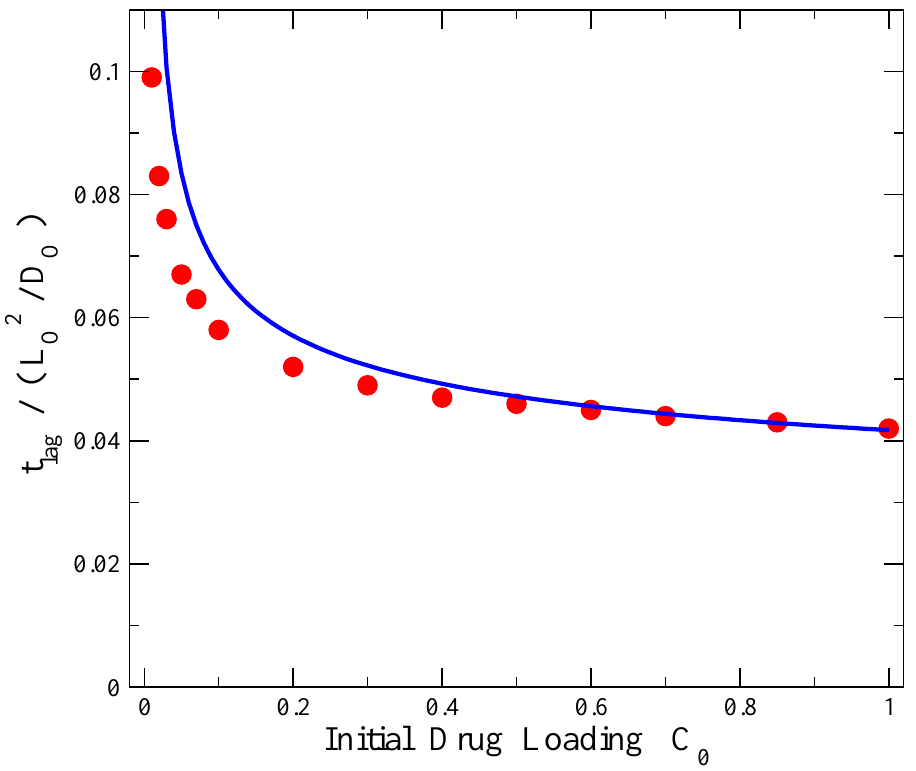
Figure 7. Dimensionless lag time, t lag / L 2 /D O , as a function of the initial concentration C 0 of the drug in the inner layer. Filled circles correspond to the numerically derived results through Monte Carlo simulations. Solid line depicts the analytical relation of Equation (5) with S = 400 and l u = 1. Finally, we investigate the scaling of lag time with the surface area S of the system (given by the lateral dimensions L x , L y of the considered slabs) or, equivalently, by the total number of drug molecules N 0 . Note that N 0 increases with the lateral size of the device as indicated by Equation (1), where S = L x L y . For this purpose, we have performed quite extensive numerical simulations in systems with increasing lateral dimensions L x = L y up to the order of a few thousands, initially loaded by up to hundreds of millions of drug particles. Different values of the other parameters of the system (L O , D O and C 0 ) have been explored in order to fully evaluate the variation of lag time with S or N 0 . Lag times averaged over 500 different Monte Carlo realizations have been obtained in all these cases. In these extensive numerical calculations, we find that the lag time decreases monoton- ically by increasing the lateral size (surface area S) or the number of drug particles, as can be observed in Figure 8. For a fixed lateral size, lag times increase when C 0 is decreased, as has been also observed in Figure 7. If the data are plotted as a function of the total number of drug molecules N 0 = C 0 L I S, instead of the lateral size S, then the results for different values of C 0 are grouped together when the other parameters are the same. This scaling of lag time with N 0 is depicted in Figure 8. Different symbols correspond to different system parameters, as indicated in the figure, exploring various initial drug concentrations C 0 from 0.1 to 1, outer layer relative diffusion coefficients D O from 0.2 to 1, and outer layer thicknesses L O from 10 to